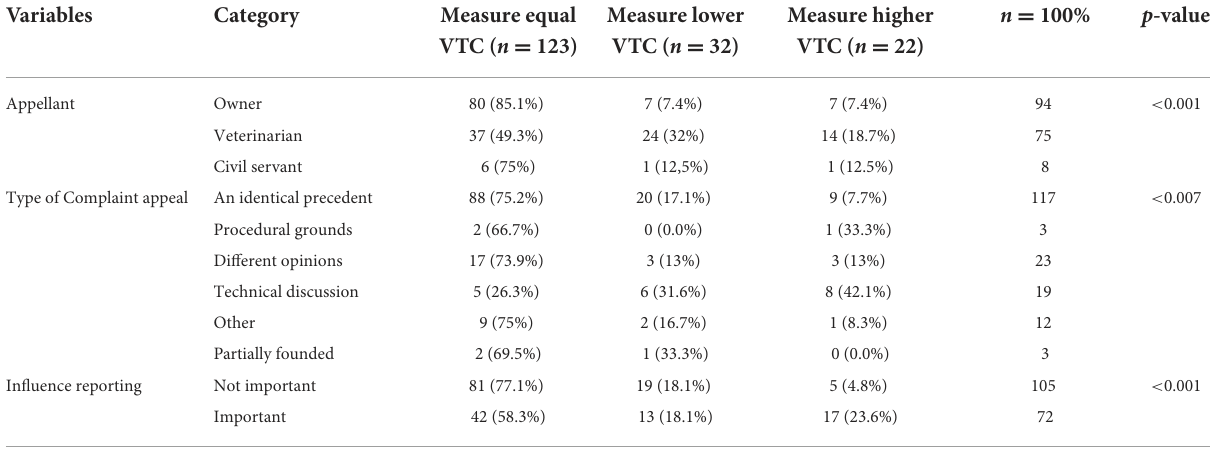
TABLE 5 Descriptive statistics for the appeal